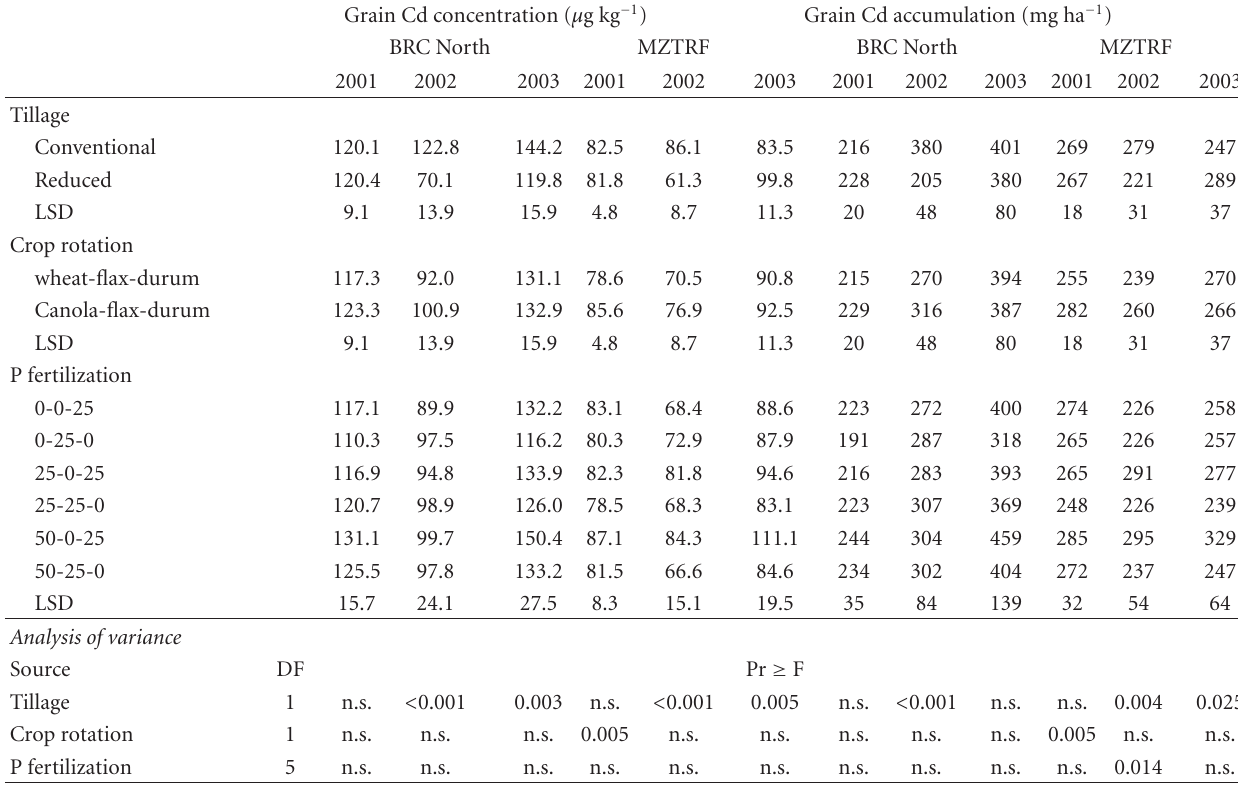
Table 4: Grain Cd concentration ( µ g kg − 1 ) and accumulation (mg ha − 1 ) of durum wheat as a ff ected by tillage system, crop rotation, and P fertilization on at two sites over 3